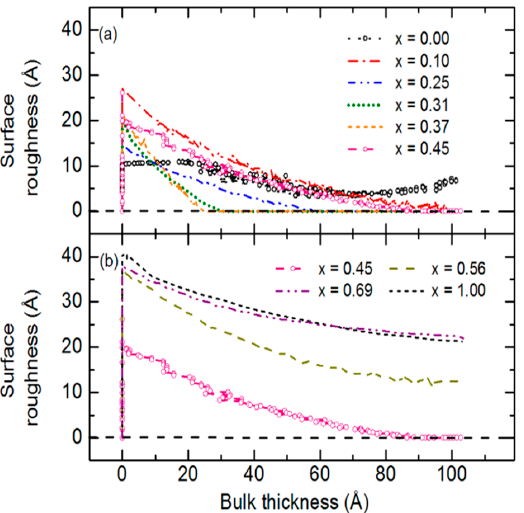
Figure 14. Evolution of the surface roughness layer thickness with bulk layer thickness for IGS films of different Ga compositions x ; ( a ) 0.00 ≤ x ≤ 0.45 and ( b ) 0.45 ≤ x ≤ 1.00. The results focus on the first 100 Å of bulk layer thickness immediately after interface filling.